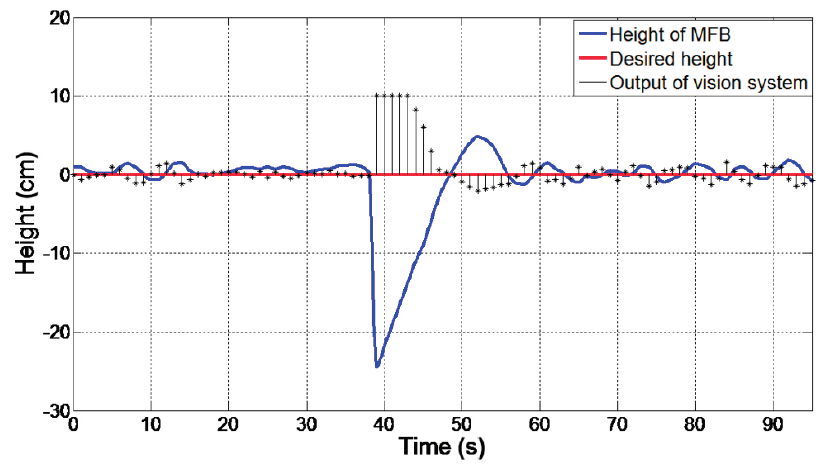
Figure 13. The response to the sudden height